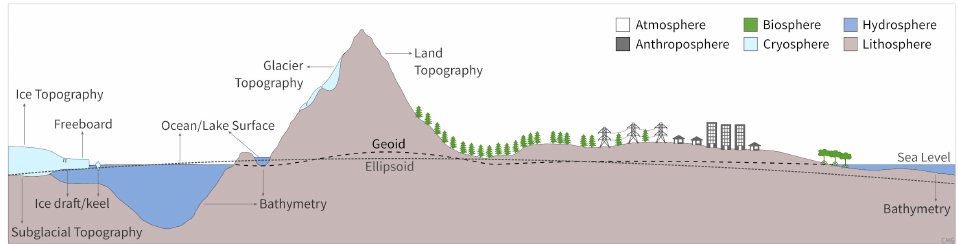
Figure 1. Possible interfaces and intermediate layers between the lithosphere and atmosphere.